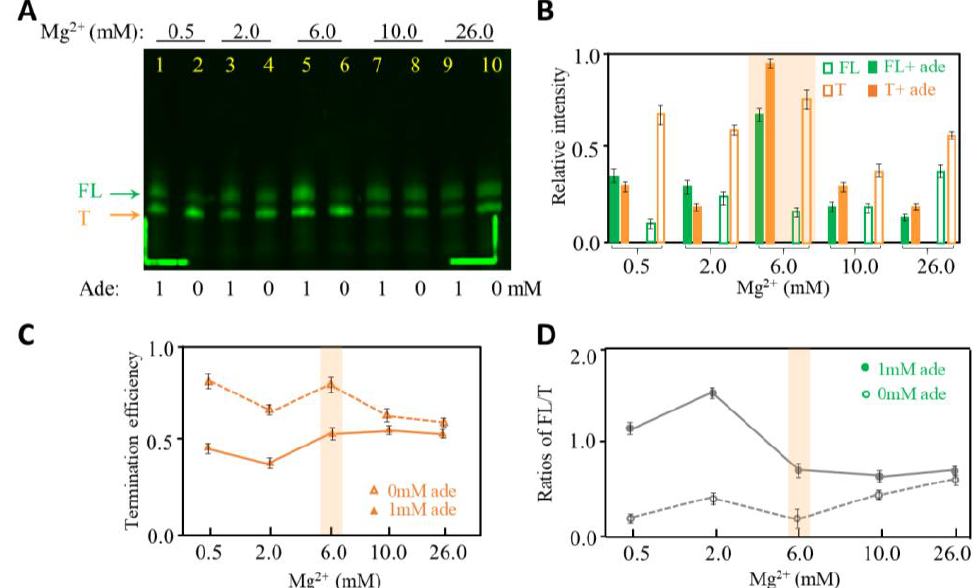
Figure 4. Transcription termination studies of adenine riboswitch at 0.5–26.0 mM Mg 2+ in the presence of 0 or 1 mM adenine. ( A ) 12% denaturing PAGE gel image of the crude products generated at 0.5–26.0 mM Mg 2+ . The gel was irradiated under fluorescence 550 nm. ( B ) The relative intensities of FL (green) and T (orange) produced at 0.5–26.0 mM Mg 2+ in the absence (in open columns) and presence of 1 mM adenine (in solid columns). The experiments were repeated three times. ( C ) Termination efficiency of adenine riboswitch transcription as a function of the Mg 2+ concentration in the absence (in open triangles) and presence of 1 mM adenine (in solid triangles). ( D ) The ratios of FL to T of adenine riboswitch transcription as a function of the Mg 2+ concentration